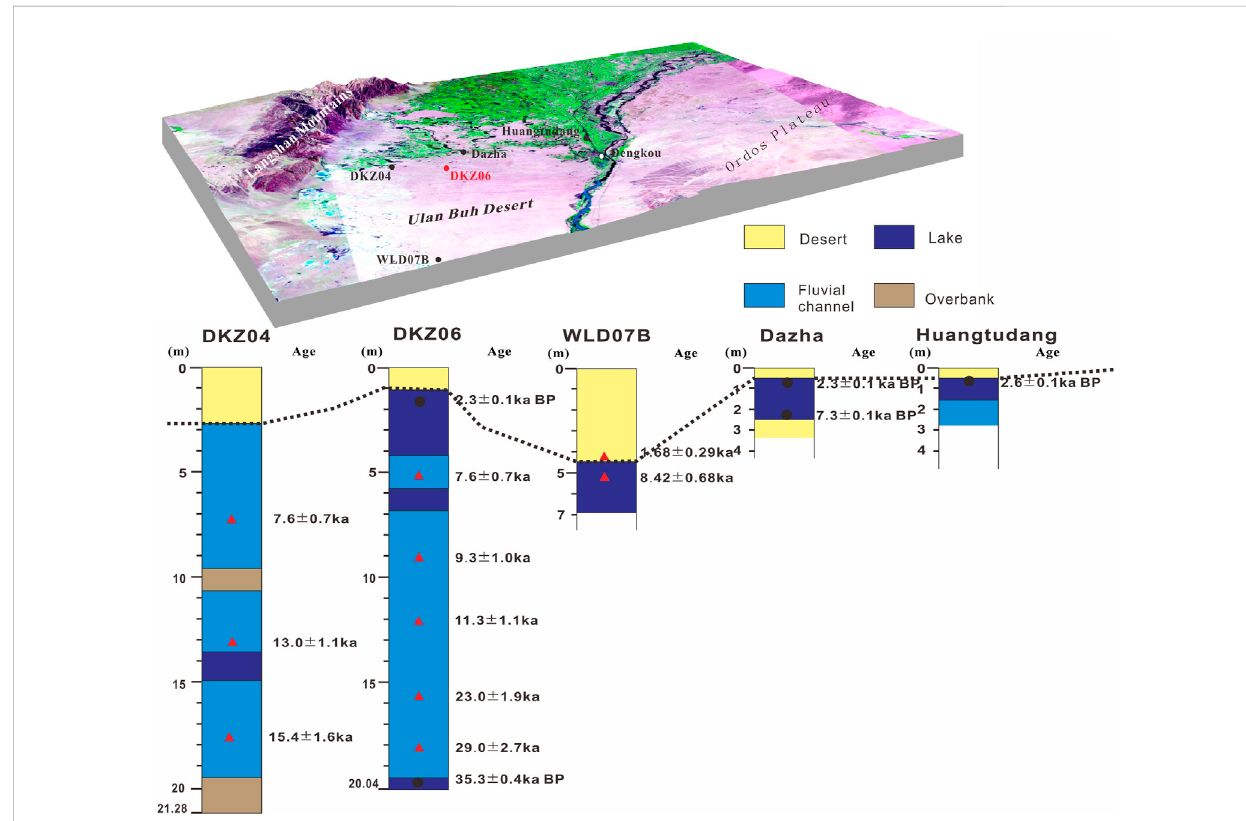
FIGURE 5 Sedimentary facies correlation of three drill cores and two sections in the Houtao Plain. The OSL and 14 C dating results of cores DKZ04, DKZ06, WLD07B, and sections Dazha, Huangtudang. Dashed lines show the correlation of the bottom of the desert sediment. The sedimentary facies and OSL ages of WLD07B are from Fan et al. (2010), and sedimentary facies and 14 C ages of sections Dazha, Huangtudang are from Jia and Yin